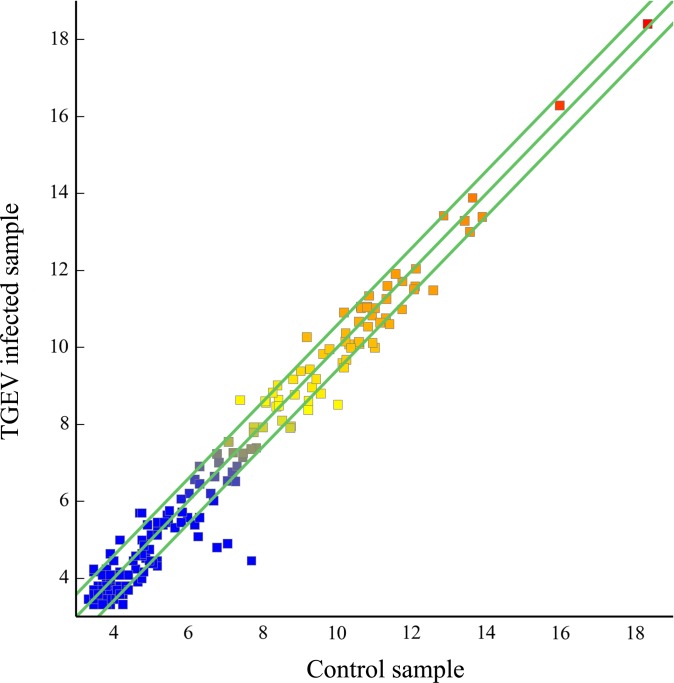
Scatter plot of the high-throughput sequencing data.The high-throughput sequencing data (differentially expressed miRNAs) are graphed on the scatter plot to visualize variations in miRNA expression between TGEV infected and control groups. The values on the X axes and Y axes of the scatter plot are the normalized values for the TGEV infected and control groups (log2 scaled). The green lines are fold-change lines (default fold-change value: 1.5).